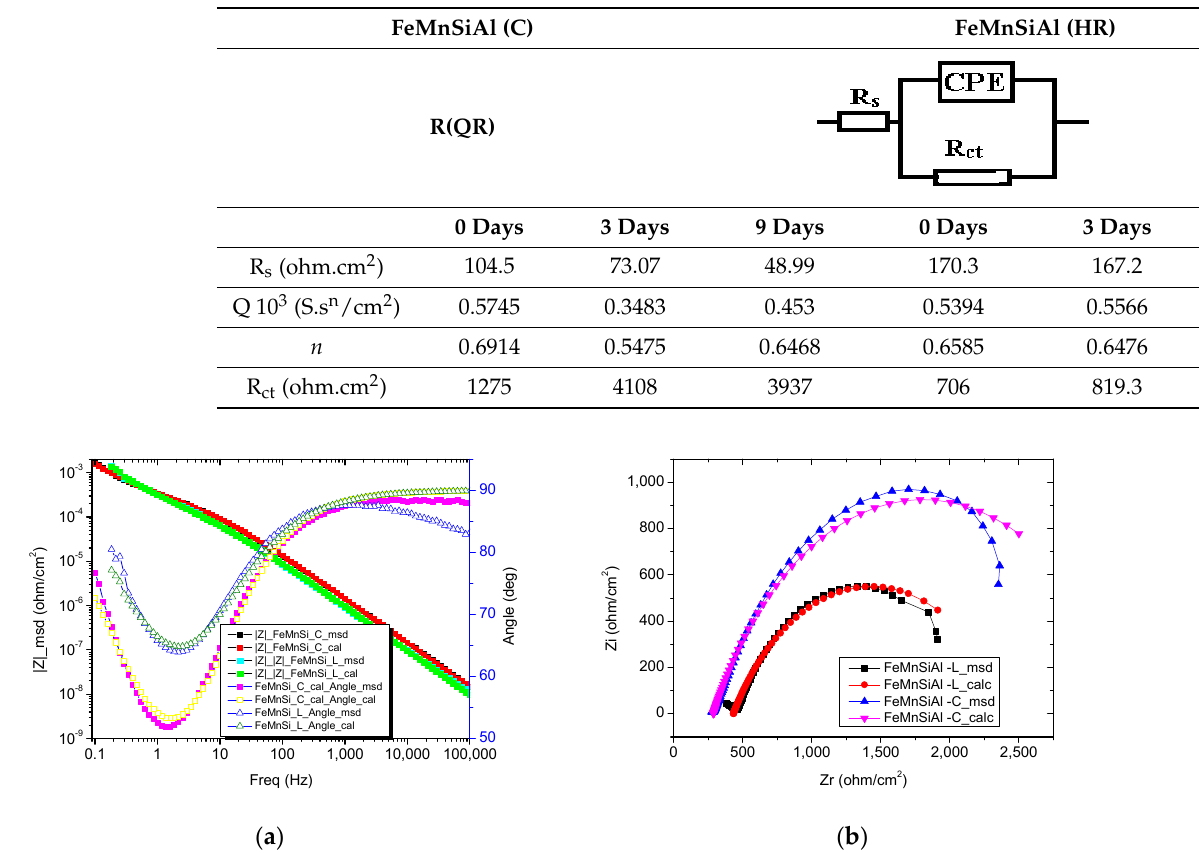
Table 7. The values of the equivalent circuit for the FeMnSiAl alloy, C, and HR samples. FeMnSiAl (C)